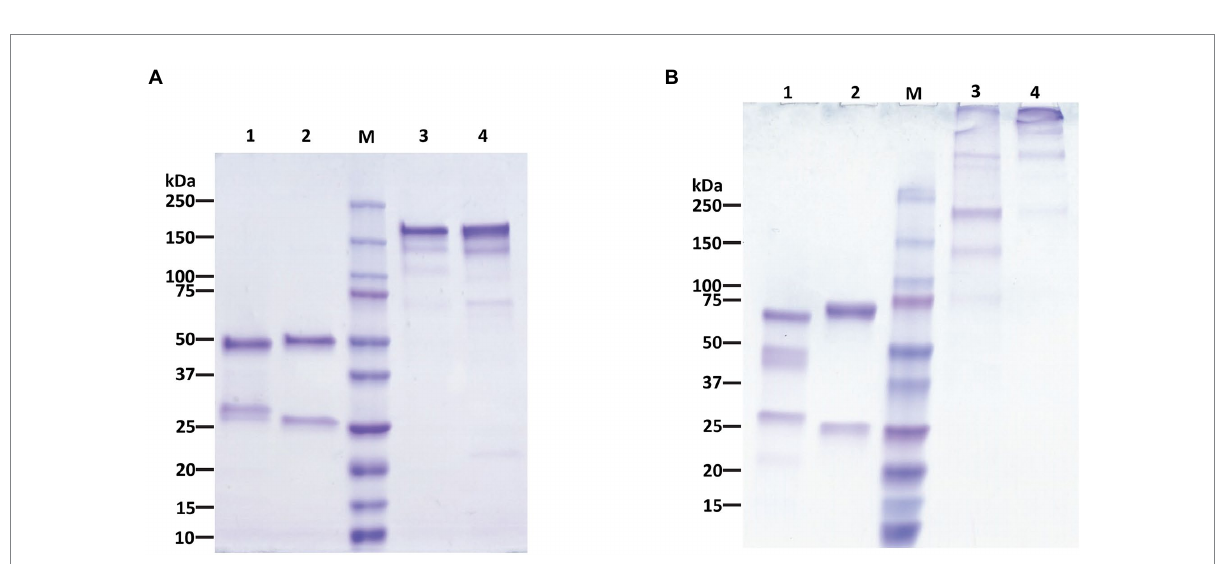
FIGURE 2 Purification of P-4H2 IgG and P-4GH2 IgM from Nicotiana benthamiana leaves. Affinity-purified, humanized P-4H2 IgG (A) and P-4H2 IgM (B) were separated by SDS-PAGE on 4%–20% polyacrylamide gels under reducing (lanes 1 and 2) and non-reducing (lanes 3 and 4) conditions. One representative of multiple experiments is shown. Lanes 1 and 3, plant-made P-4H2 IgG (A) or P-4H2 IgM (B) . Lanes 2 and 4, human IgG (A) or IgM (B) isotype control. M, molecular weight marker. 2.5 μ g of protein was loaded per